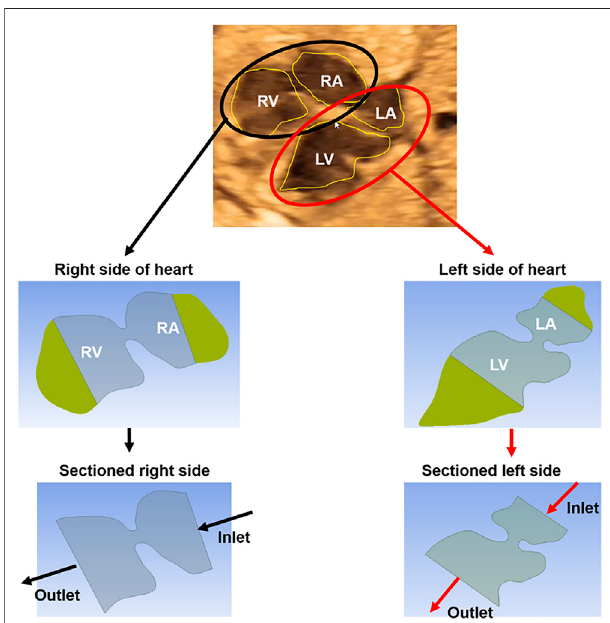
FIGURE 1 | The methodology of CFD analysis. A sample ultrasound image of a 23-week control heart is used to demonstrate the methodology. First, the ultrasound-based geometric models are generated by determining the borders of the heart chambers. The left and right sides of the hearts are modeled and analyzed separately. The heart chambers are sectioned to apply the boundary conditions at the inlet and outlet of the fetal heart models. Inlet fl ow pro fi les are adjusted up to reaching the clinical velocity levels at the mitralandtricuspidvalveswhicharemeasured via Dopplerechocardiography. The mitral and tricuspid valves are in the left and right sides of the heart, respectively.